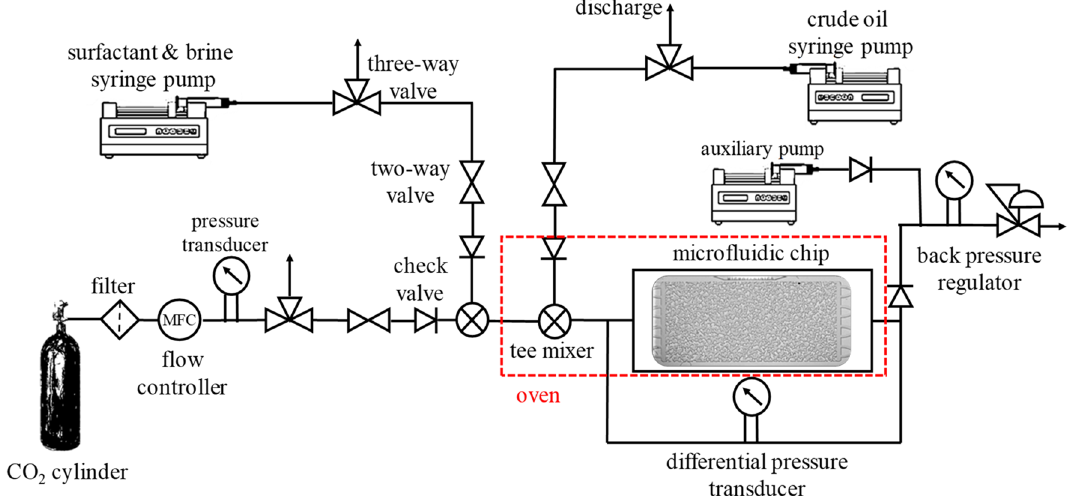
Fig. 2 Schematic of the microfluidic